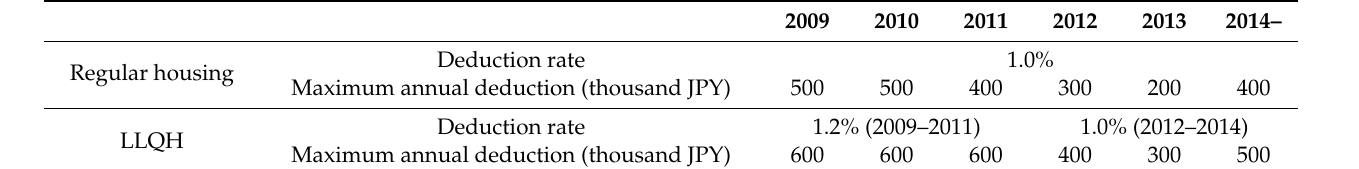
Table 2. Preferential measures for housing loans for